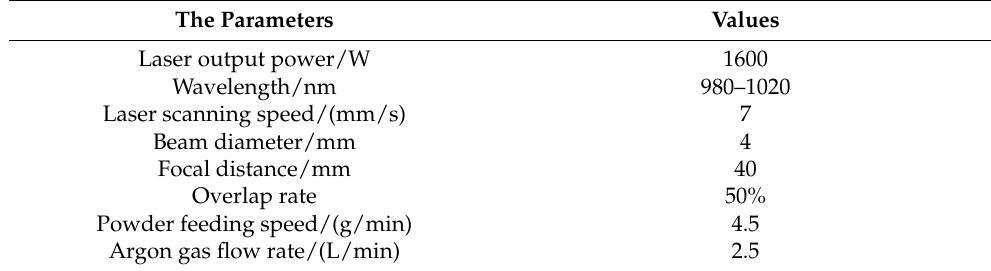
Table 2. Parameters of the laser alloying